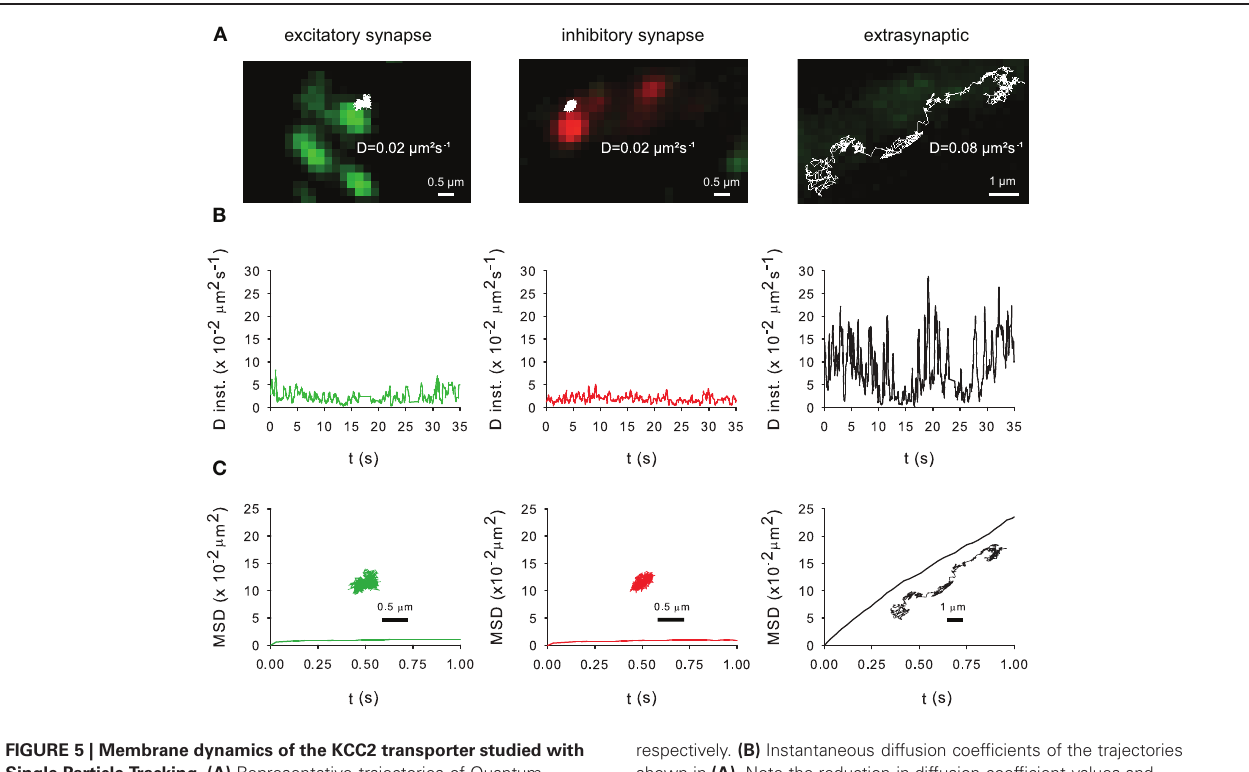
respectively. (B) Instantaneous diffusion coefficients of the trajectories shown in (A) . Note the reduction in diffusion coefficient values and fluctuations for synaptic/perisynaptic QDs as compared with the extrasynaptic QD. (C) Time-averaged MSD functions of the trajectories shown in (A) . Extrasynaptic and synaptic QDs display linear and negatively bent MSD curves, characteristic of random walk and confined movement, respectively. In all graphs: green and red curves, trajectories at/near excitatory and inhibitory synapses, respectively; black, extrasynaptic